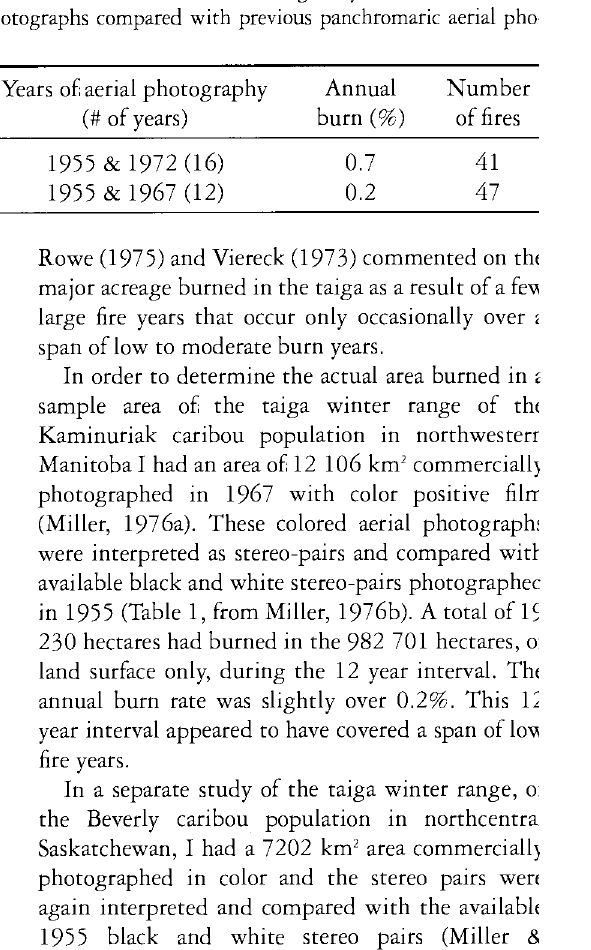
Table 1. Area burned during a 16-year interval in northcentral Saskatchewan and during 12 years in northwesteri Manitoba as determined from colored aerial photographs compared with previous panchromaric aerial pho tographs.